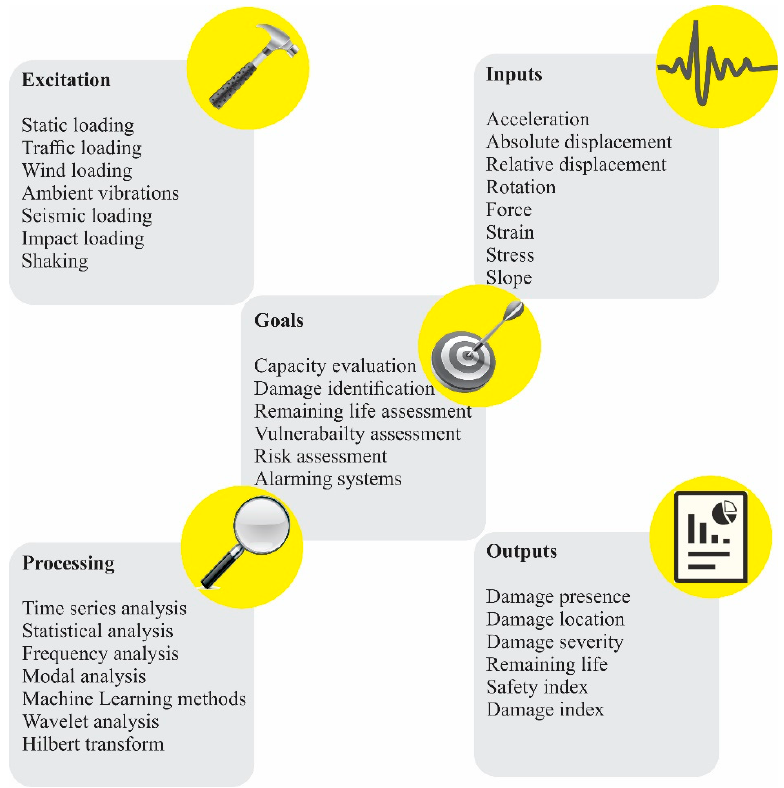
Figure 1. Five main components of vibration-based SHM.